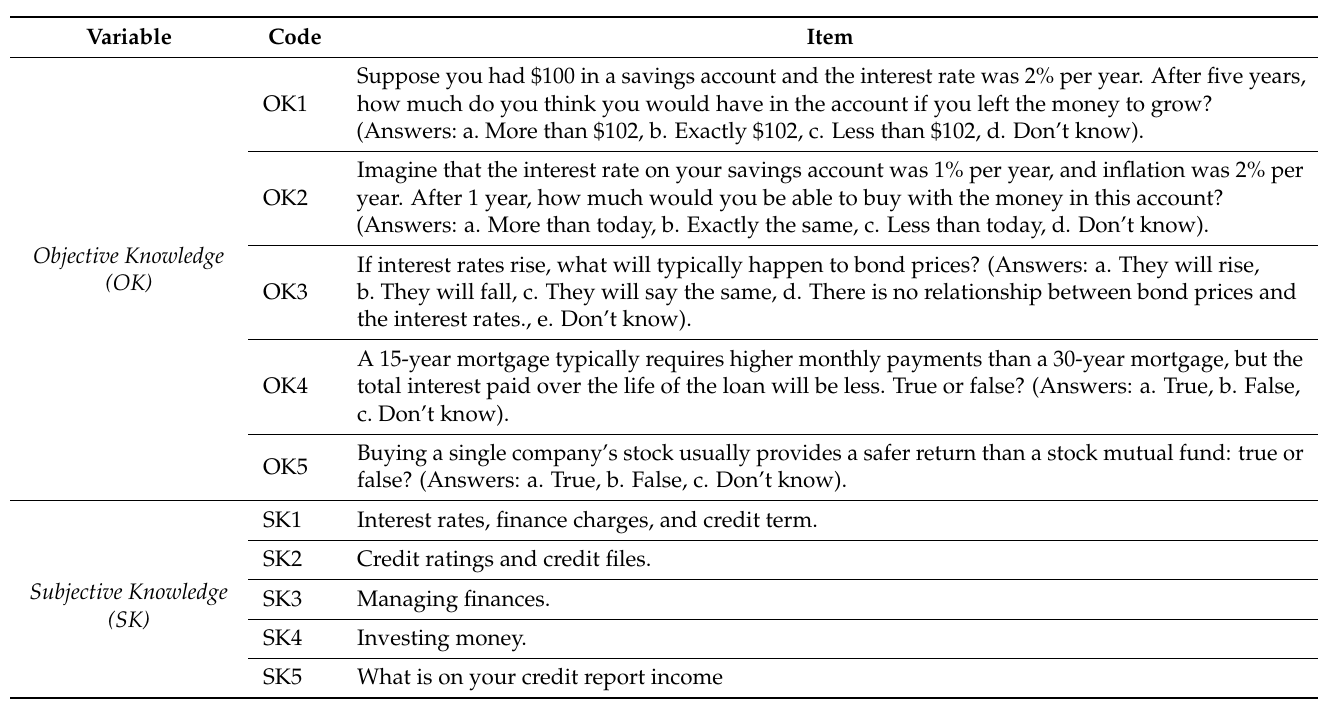
Table 1. The scale used to measure the research